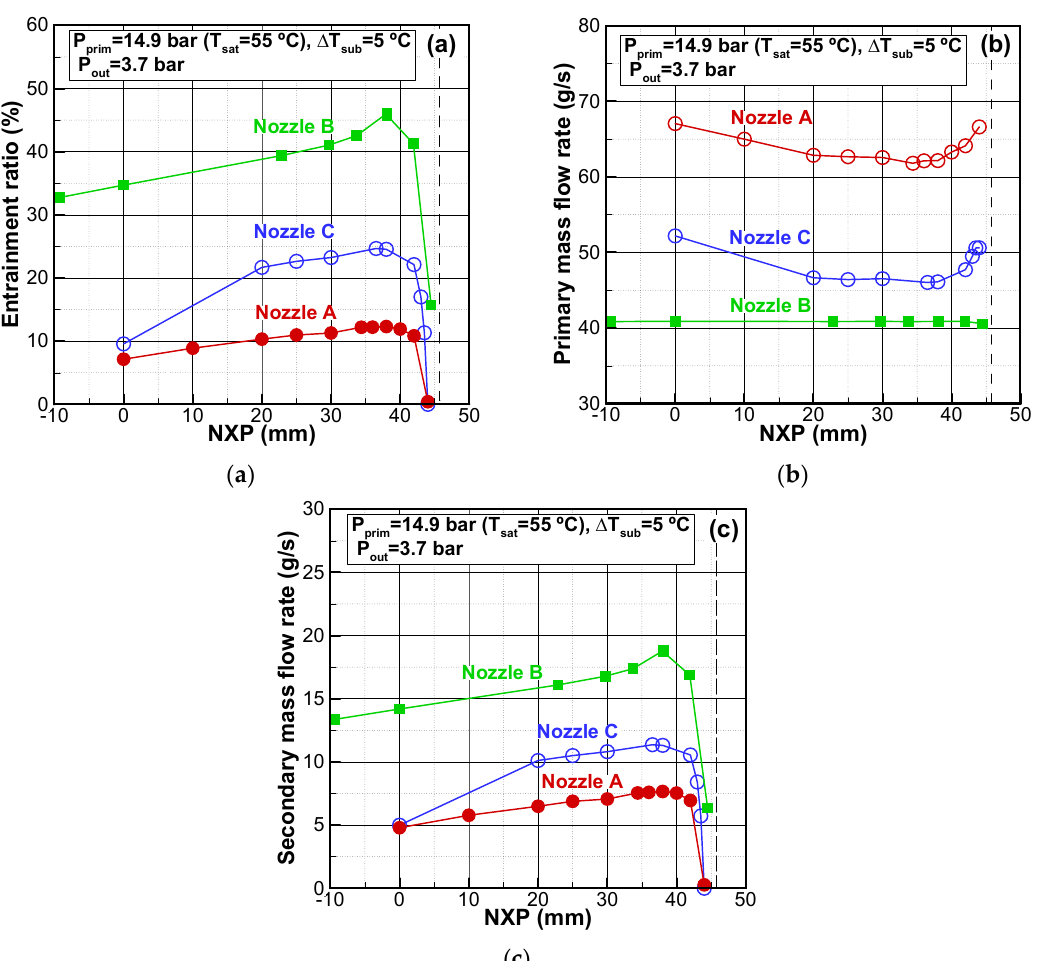
Figure 8. Effects of the NXP and nozzle geometries: ( a ) Entrainment ratio; ( b ) Primary mass flow rate; ( c ) Secondary mass flow rate.